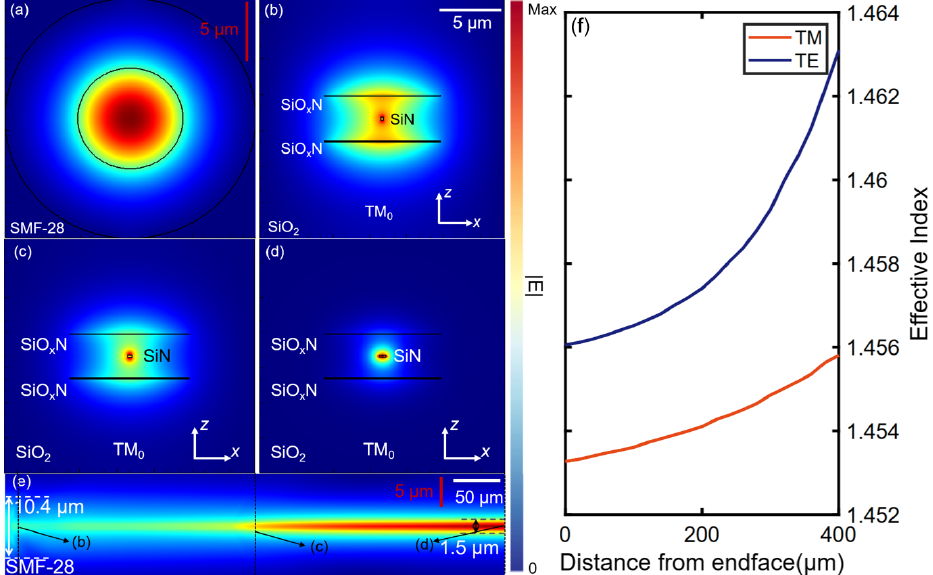
Figure 2. ( a ) TM mode profile of the SMF-28. ( b ) TM Mode field at the end face of the edge coupled structure. ( c ) TM mode field distribution at 200 nm from the end face. ( d ) TM mode field distribution at 400 nm from the end face. ( e ) TM mode evolution along the coupler (0–400 μm) in the XOY plane. ( f ) The relationship between the effective index and the distance from the end face in TE and TM